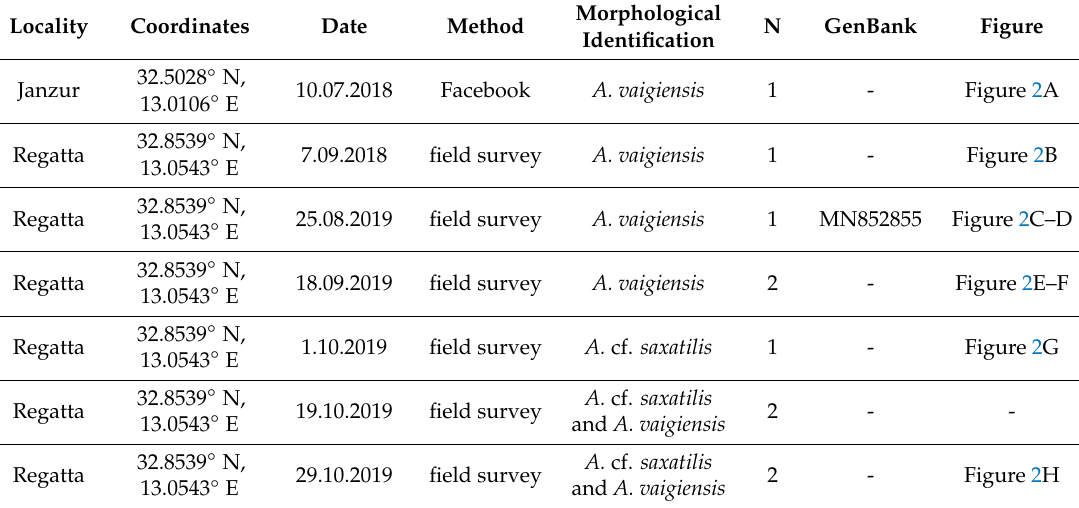
Table 2. Records of specimens belonging to the genus Abudefduf Forsskål, 1775 from Libya, with locality, coordinates, date, method of observation, morphological identification, number of specimens (N), GenBank accession number, and figures (see Figure